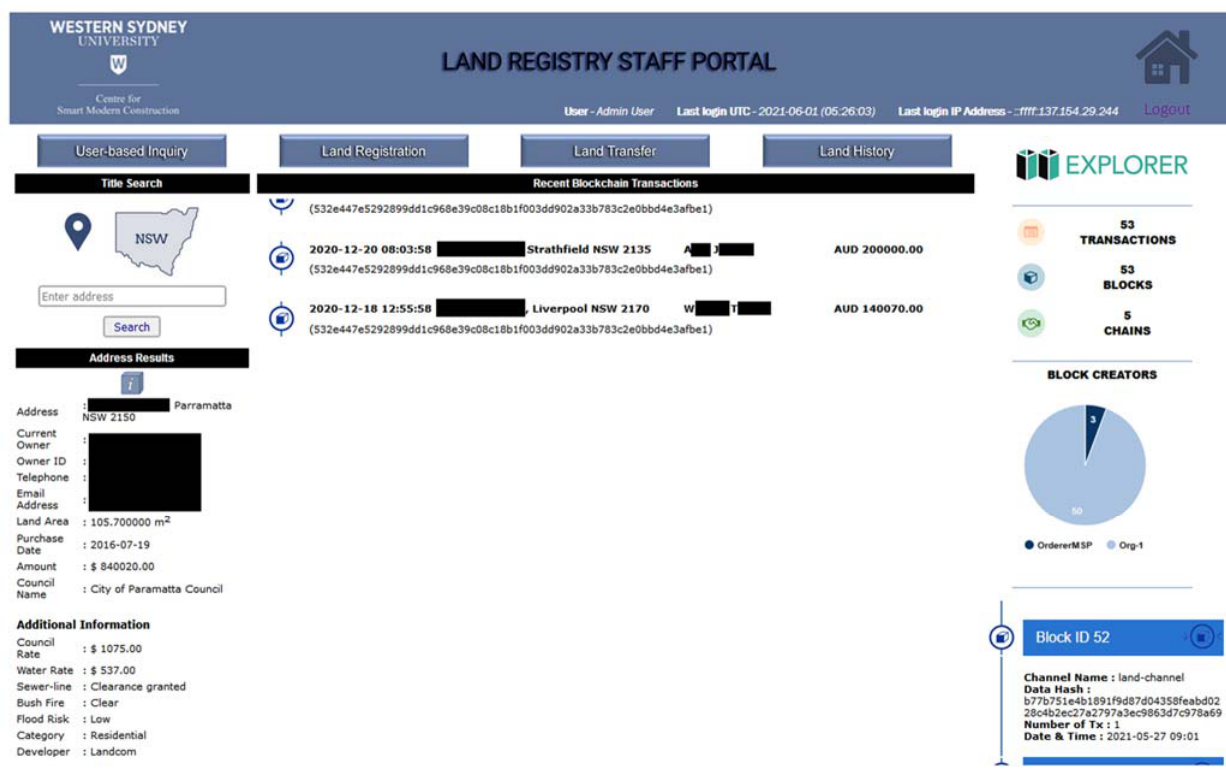
Figure 9. Output of title search blockchain query function available for land registry administration.